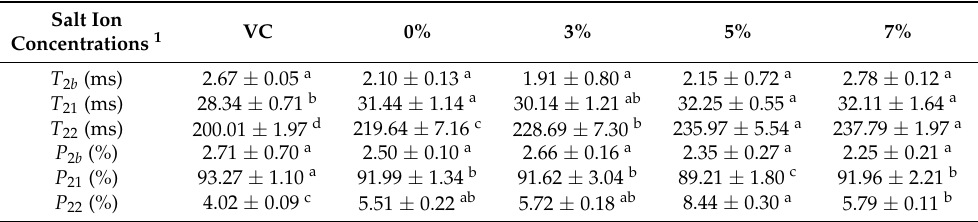
Figure 4. Three-dimensional waterfall plot showing the T 2 changes in the chicken drumsticks in different cooling treatments generated with Origin 8.5. ( T 2 : transverse relaxation time; VC: vacuum cooling; 0%, 3%, 5%, and 7%: salt ion concentrations in immersion solution during immersion vacuum cooling). Table 4. Effects of immersion solutions with different salt ion concentrations on the transverse relaxation time ( T 2 ) of